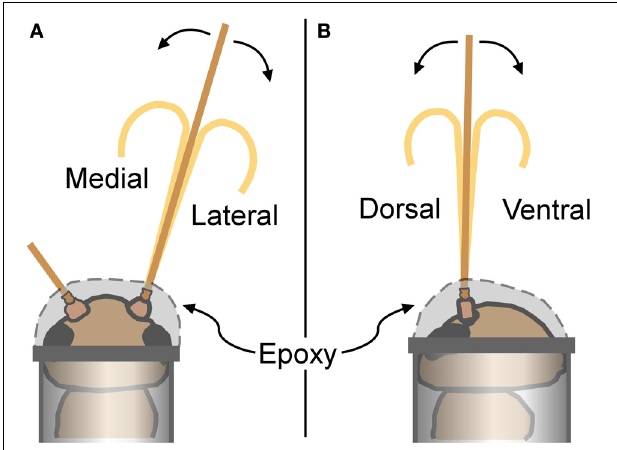
FIGURE 4 | Cricket restraints and bending directions. For antennal bending measurements, crickets were placed into plastic tubes, and attached with epoxy that secured the base of the antenna (epoxy covered the scape, pedicel, and the first few flagellomeres). (A) Antennae bent in a medial or lateral direction were viewed from a dorsal perspective as illustrated. (B) Antennae bent in a dorsal or ventral direction were viewed from a lateral